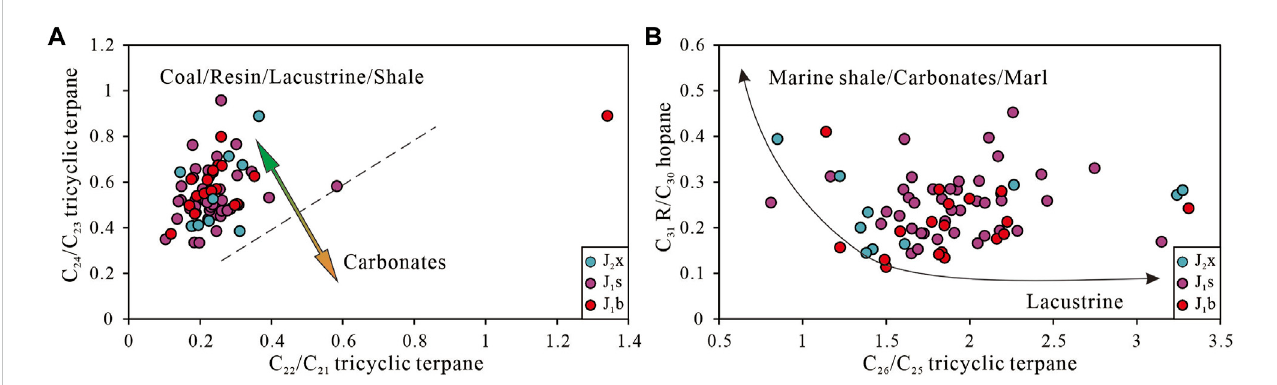
FIGURE 8 (A) C 24 /C 23 vs C 22 /C 21 tricyclic terpane and (B) C 31 R/C 30 hopane vs C 26 /C 25 tricyclic terpane of the Jurassic organic-rich shale in the East Fukang Sag, Junggar Basin, China (modi fi ed after Peters et al.,